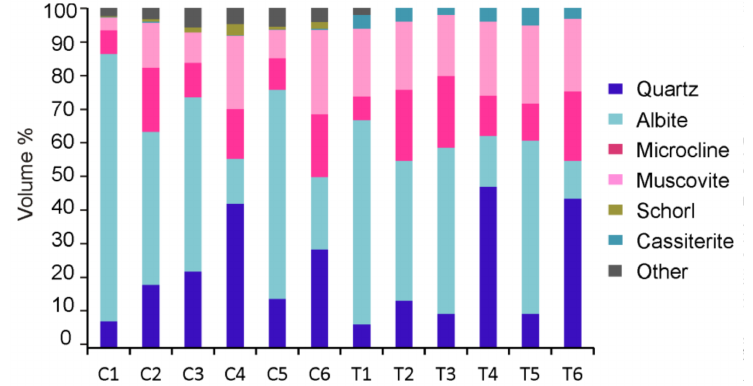
Figure 6. Modal mineralogy of the grinding products. C1 to C6 are the concentrates analyzed by a Tescan Integrated Mineralogical Analyzer (TIMA-X) and in tailings (T1–T6) determined by X-ray powder diffraction